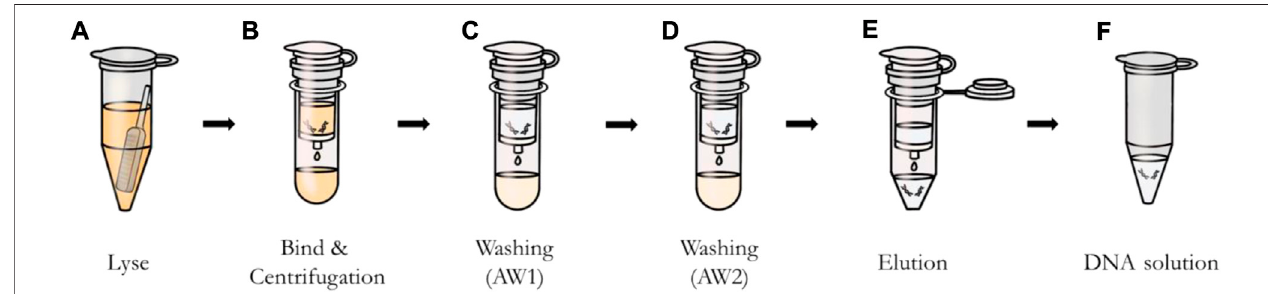
FIGURE 3 | DNA extraction process using QIAamp DNA mini kit. (A) Lysis of sample from swab. (B) Bond of DNA to the column by applying and centrifuging the solution through the column. (C) and (D) Removal of impurities except DNA with buffers AW1 and AW2. (E) Elution of DNA bound to the column using buffer AE. (F) Extracted DNA